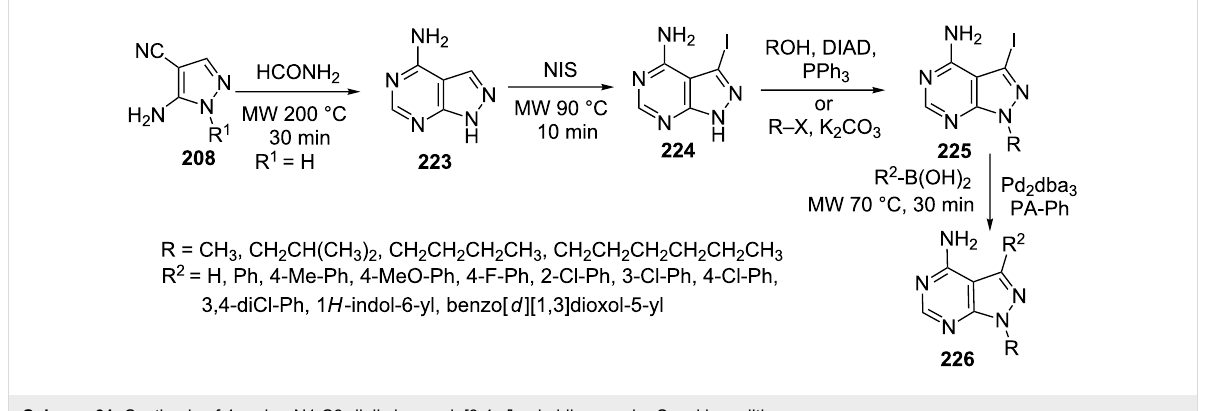
Synthesis of pyrazolo[3,4- b